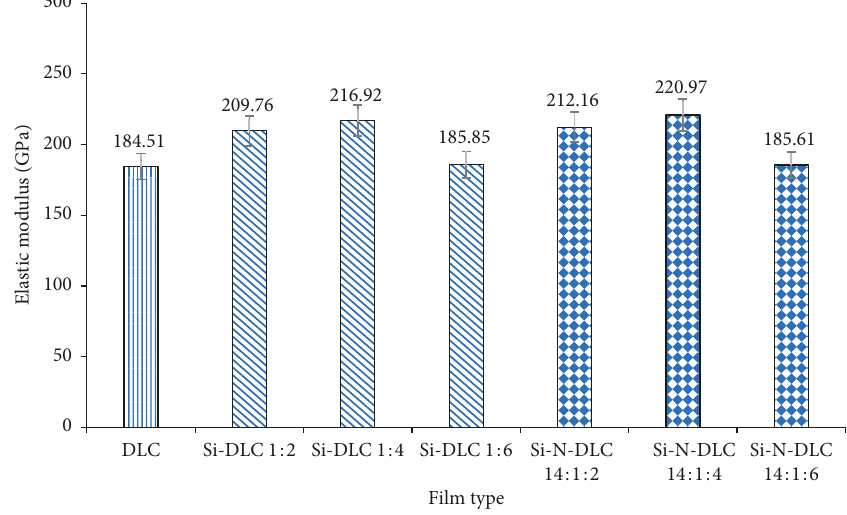
Figure 7: Elastic modulus of pure DLC, Si-DLC, and Si-N-DLC films. Table 4: Mechanical properties and friction coefficient of pure DLC, Si-DLC, and Si-N-DLC films. Film type